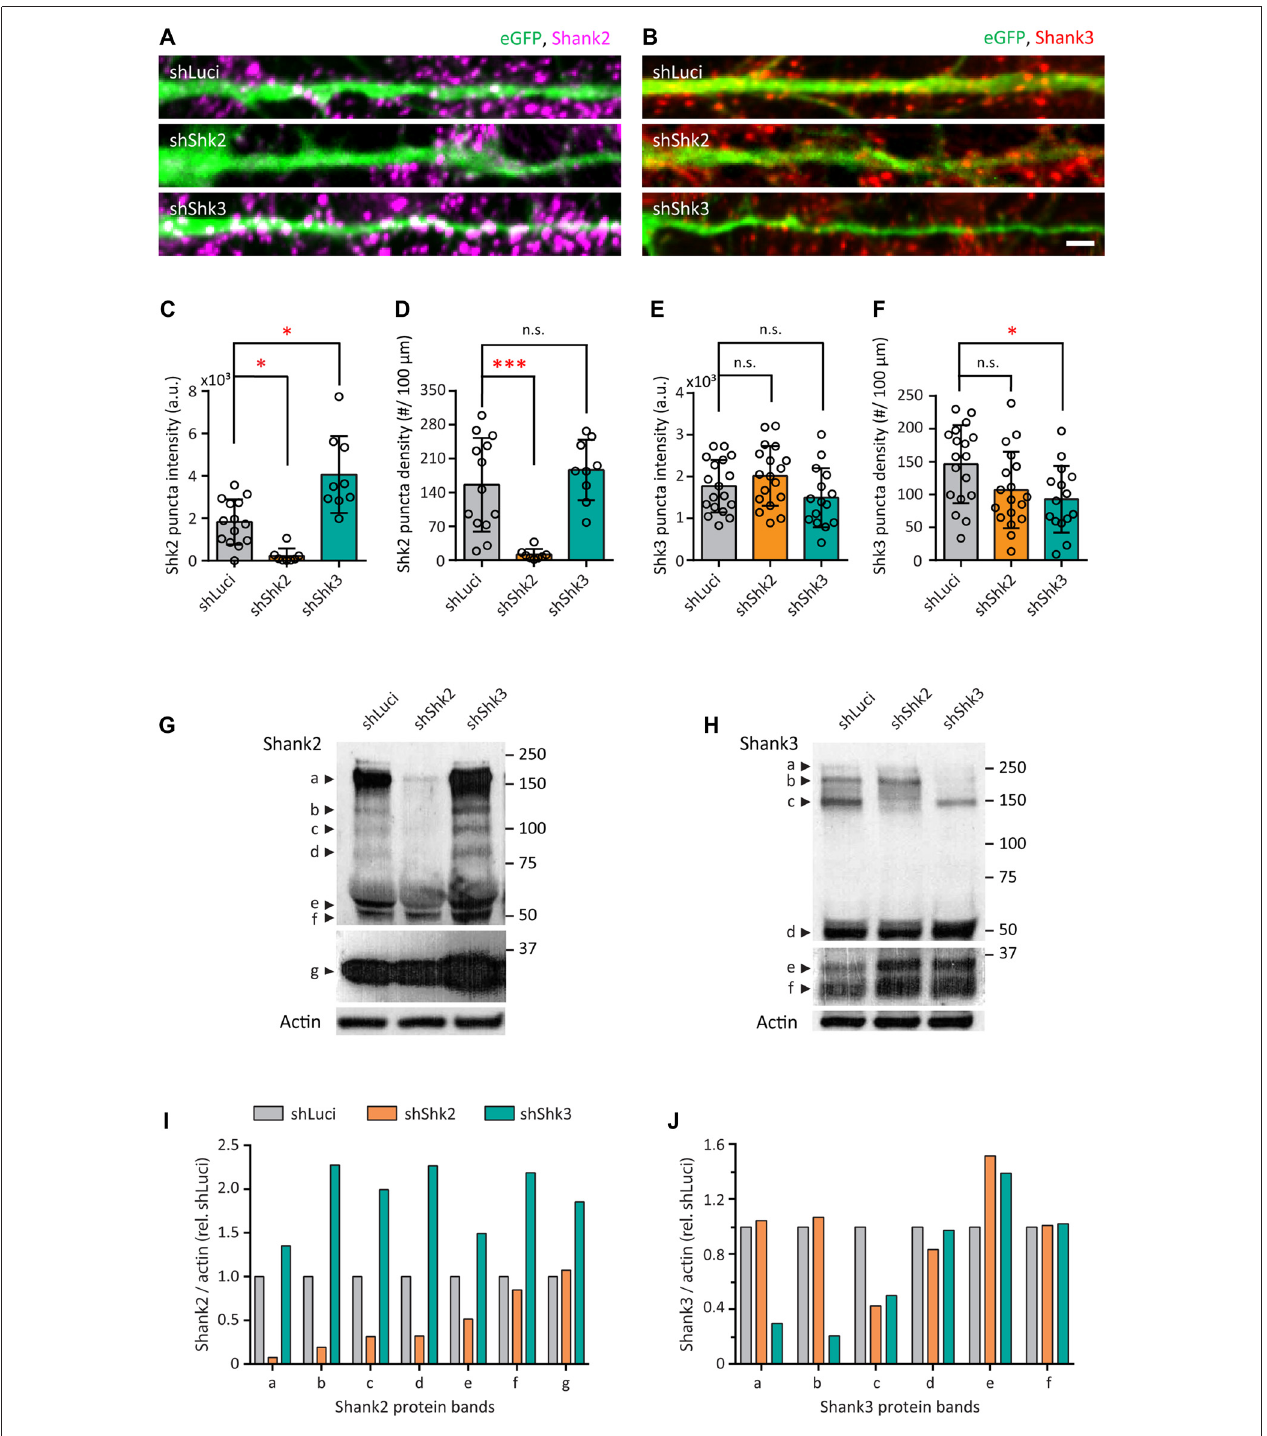
FIGURE 10 | Short-hairpin RNA (shRNA)-mediated knockdown of Shank2 and Shank3. (A,B) Straightened dendrites of transfected hippocampal neurons expressing a bicistronic construct with enhanced green fluorescent protein (eGFP; green) and shRNA hairpins for shLuciferase (shLuci, top), shShank2 (shShk2, middle) or shShank3 (shShk3, bottom) and immunostained for Shank2 (magenta; A ) or Shank3 (red; B ) after 14 DIV. Scale bar: 5 µ m. (C–F) Summary graphs showing quantification of Shank2 (C,D) and Shank3 (E,F) puncta intensity and density (mean ± SEM) for different knockdown conditions (Kruskal-Wallis one-way ANOVA with Dunn’s correction post hoc multiple comparisons, Shank2 staining: shLuci, N = 14; shShk2, N = 8; shShk3, N = 9 dendrites from 8 to 12 neurons from three culture preps. Shank3 staining: shLuci, N = 18; shShk2, N = 18; shShk3, N = 15 dendrites from 8 to 12 neurons from three culture preps; n.s. p ≥